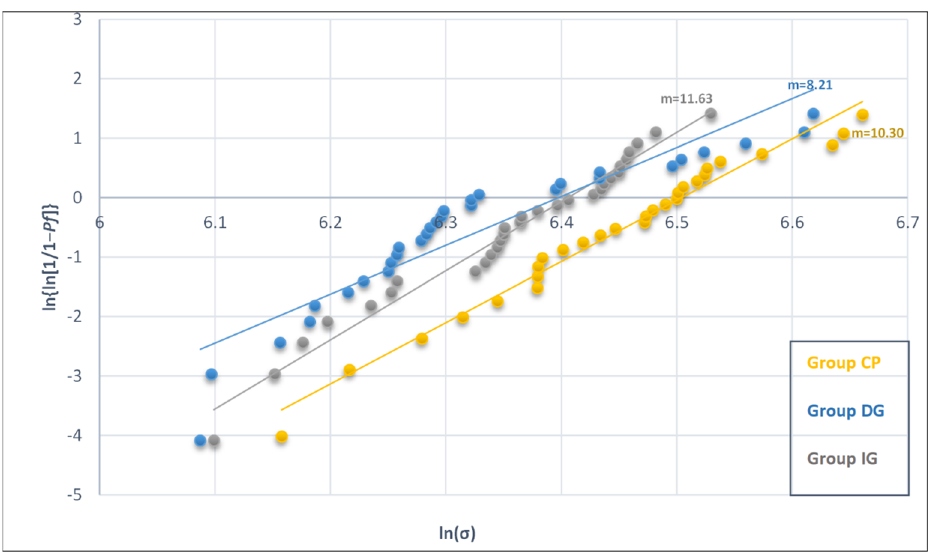
Figure 7. SEM image showing the presence of voids in the glaze layer and a red arrow showing the direction of crack propagation at 500x magnification (group DG).